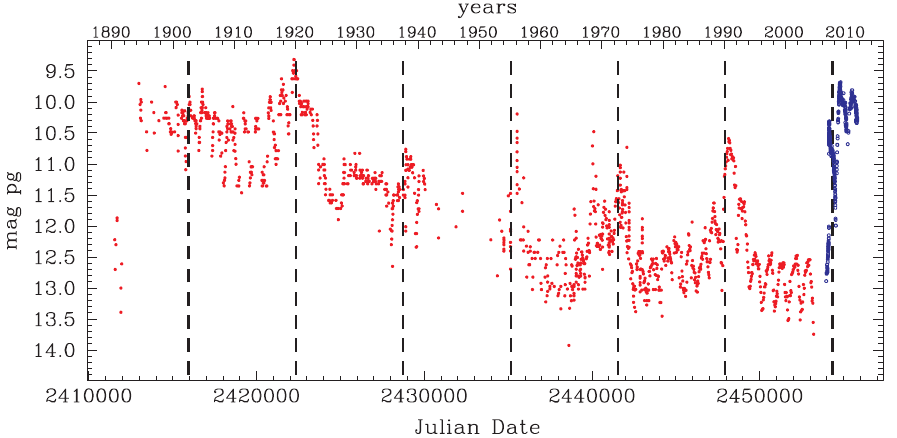
Fig. 1. Historical light curve of BF Cyg. Data prior to 2006 are from Jacchia 1941, Skopal et al. 1995 and AAVSO. The vertical dashed lines mark the 6376 d periodic vari- ability found by Leibowitz & Formiggini (2006). Blue open circles are ANS Collaboration